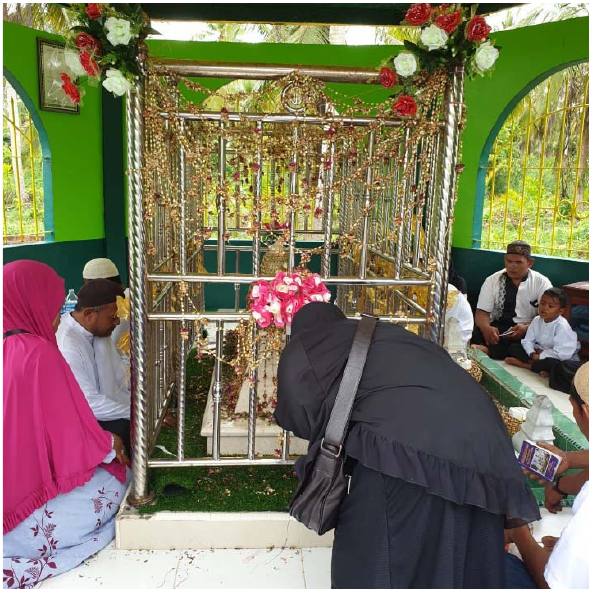
Figure 1. Pilgrims praying at the grave of Tuan Guru Sapat (Abdurrahman Siddiq) in Tembilahan (Source: Authors’ collection).